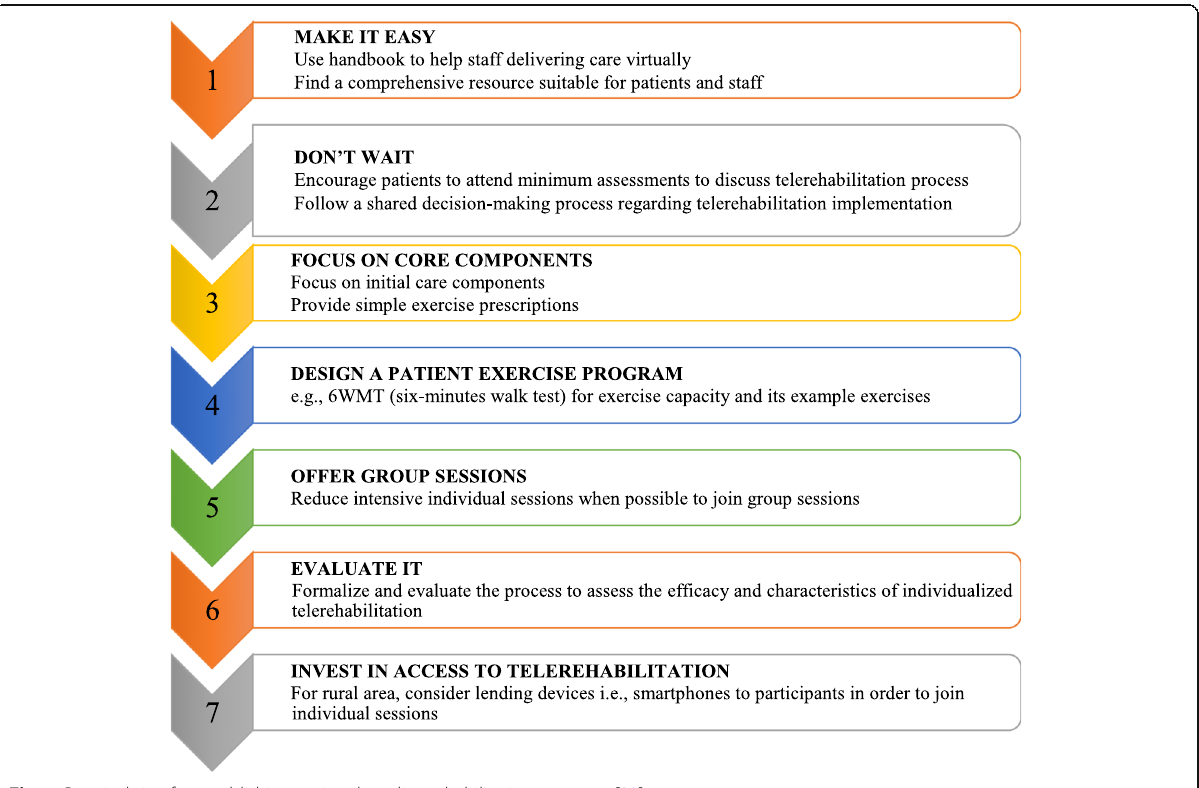
Fig. 1 Practical tips for establishing a virtual cardiac rehabilitation program